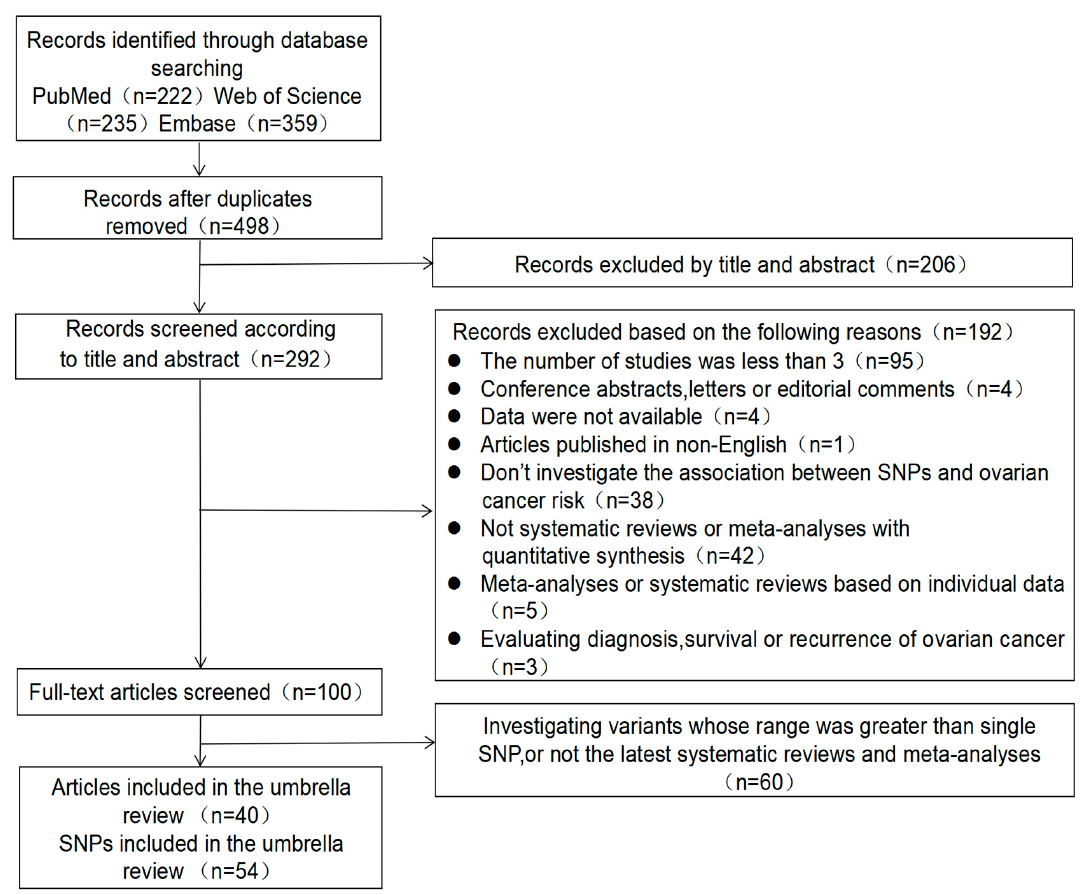
Figure 2. The screening process of articles.